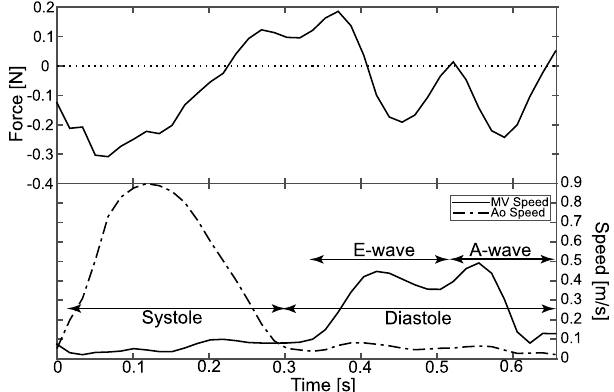
Figure 4. (Top panel) Hemodynamic force [N] where a direction of the vector is considered positive if it is mainly directed towards atrium and negative if it is mainly directed towards apex. (Bottom panel) Speed data [m/s] extracted from the 4D flow data at points near the mitral valve (MV) orifice and the aortic valve (AoV) orifice. These speed curves in combination with streamline visualizations are used to divide the cardiac cycle into systole and diastole, the latter with subphases of early (E) and late (A) filling. The x-axis shows time in seconds from